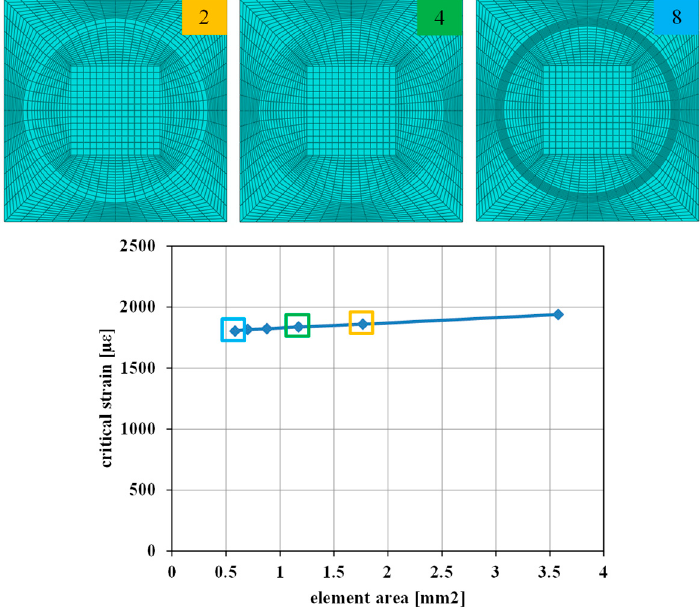
Figure 9. Influence of the element discretization in the radial direction on the critical propagation strain.